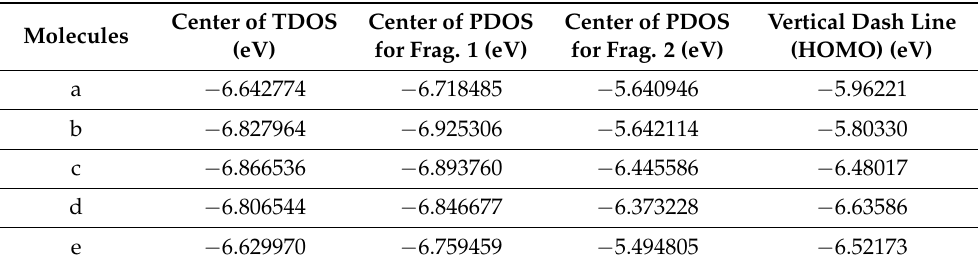
Table 2. Energy of population densities of states for the binary mixtures ( α -cubebene–water (a), β -caryophyllene–water (b), caryophyllene oxide–water (c), 1,8-cineole–water (d), and β -pinene– water (e)) (frag. 1—pure molecule; frag. 2—binary mixture with water). Center of Molecules